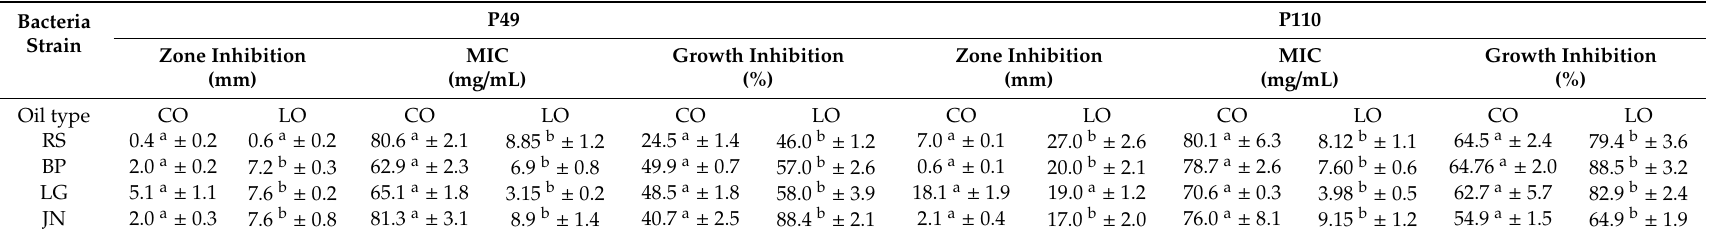
Table 3. Comparison of antibacterial activity of commercial oils and oils obtained by the